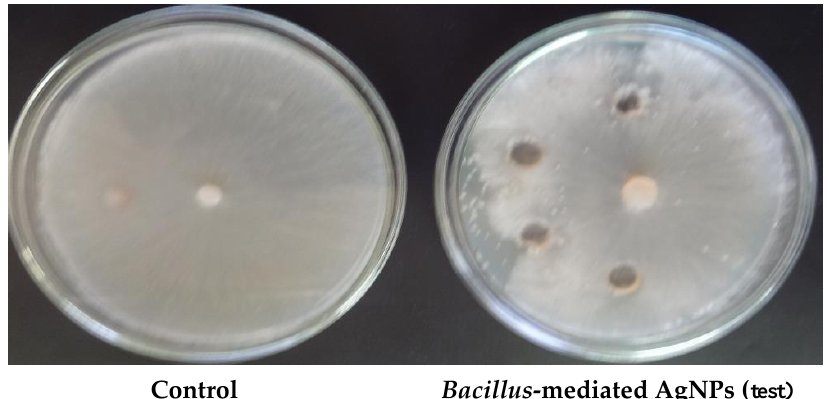
Figure 4. Antifungal activity of Bacillus species-mediated AgNPs (Bs-AgNPs) against R. solani.